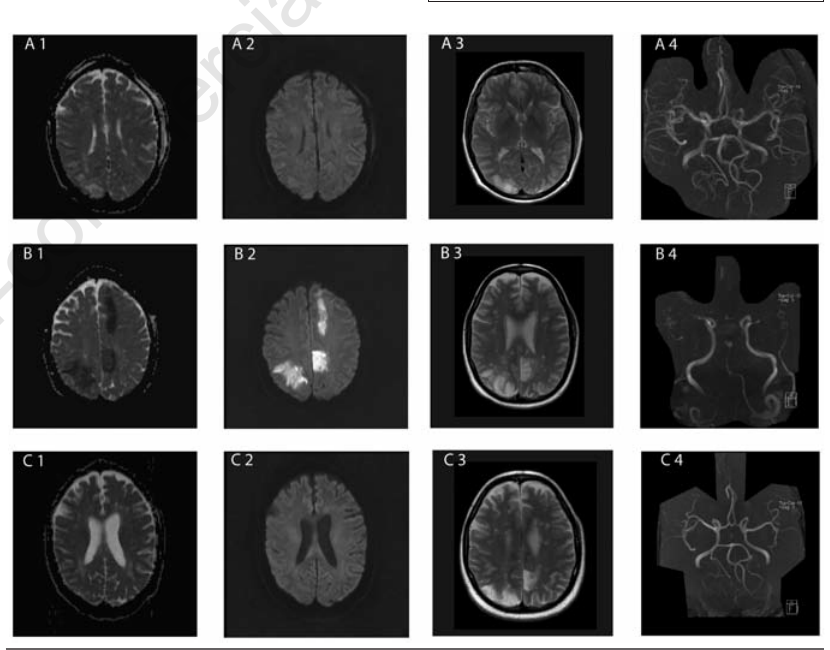
Figure 1. A1-A4: magnetic resonance (MR) images on admission of patient #1, showing hyperintensities (vasogenic edema) on ADC (apparent diffusion coefficient; A1), DWI (diffusion weighted imaging; A2) and T2-weighted (A3) images, accentuated in the right occipital pole. There were no vessel abnormalities on TOF-MRA (time of flight magnetic resonance angiography; A4). B1-B4: 10 days later, MR images show multiple ADC hypointensities (B1) and DWI hyperintensities (B2) on corresponding levels, typical for infarction. Vasogenic edema is still evident on T2-weighted images (B3). TOF-MRA (B4) reveals severe and multiple vasoconstriction. C1-C4: follow-up MR images after four months show no abnormalities in ADC (C1) and DWI (C2) maps. On T2-weighted images (C3), old cerebral infarctions are evident. TOF-MRA (C4) demonstrates complete resolution of cerebral